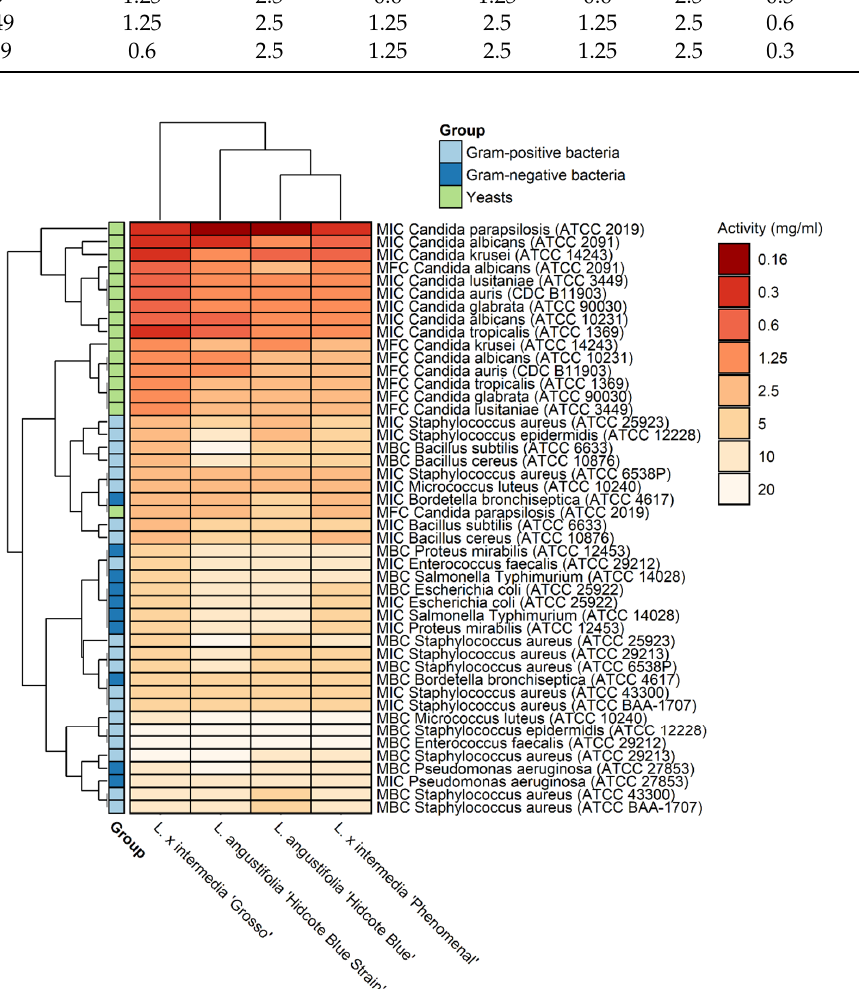
Figure 2. Heatmap illustrating antimicrobial activity (MIC, MBC, and MFC doses) of analysed essential oils against tested microorganisms. Hierarchical clustering was performed using the complete method applied to Canberra distances. Heatmap was made using pheatmap 1.0.12 and ggplot2 3.3.6 packages in R version